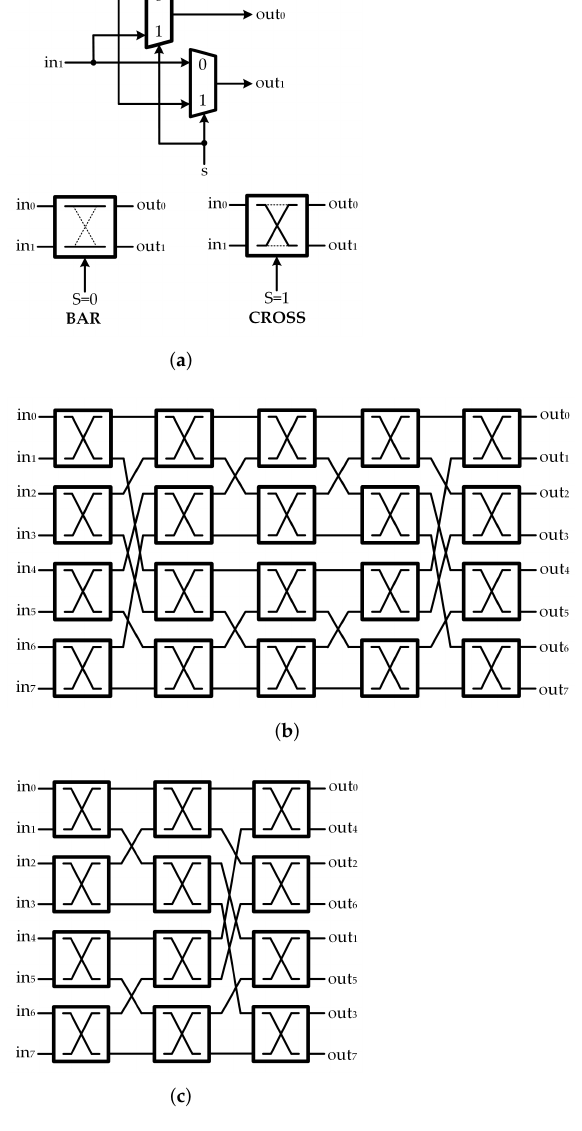
Figure 1. ( a ) Benes network 2 × 2 switch; ( b ) Benes network when P = 8; ( c ) Banyan network when P =